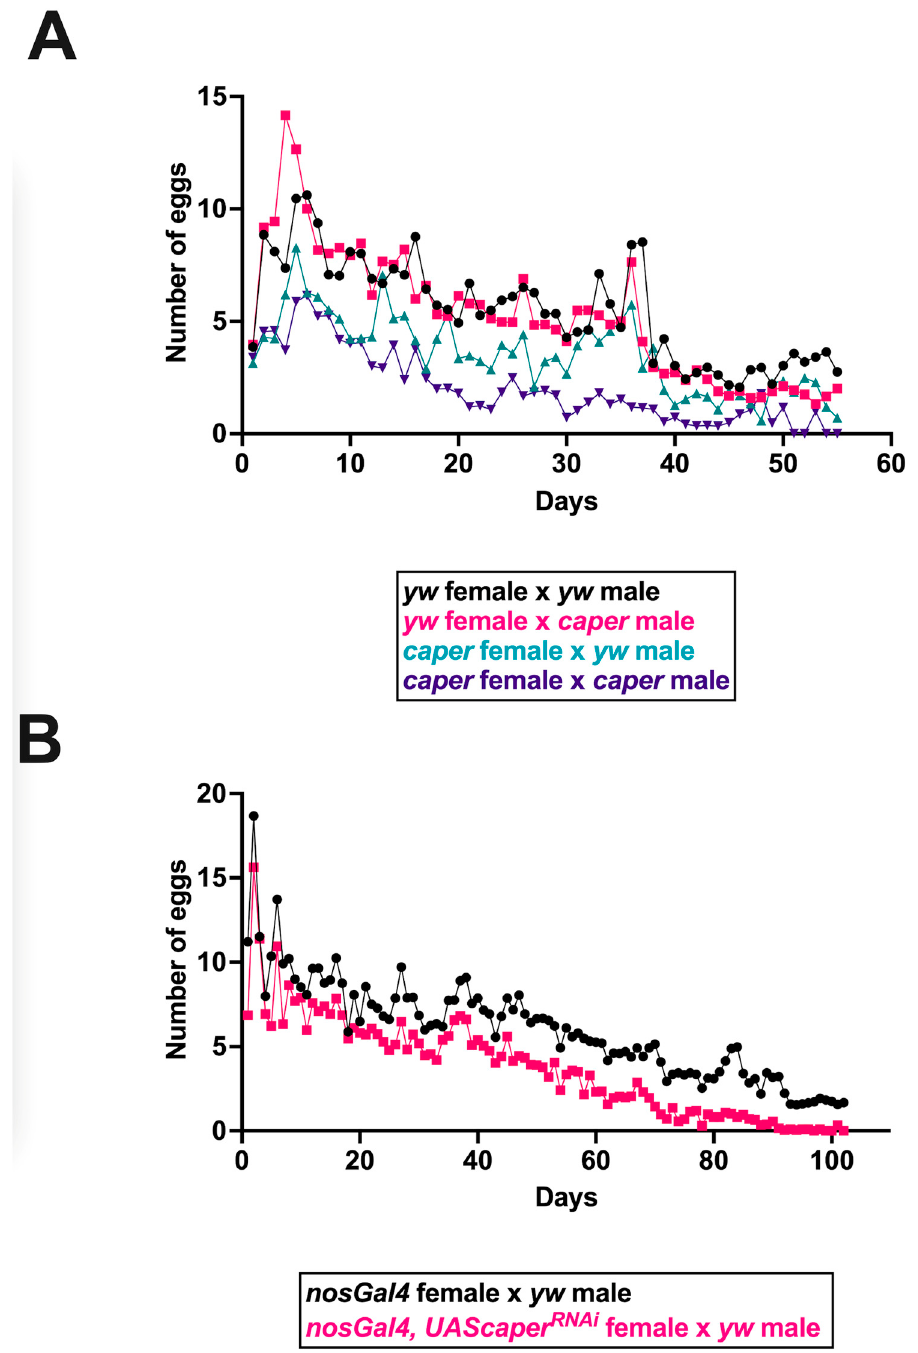
Figure 2. Reproductive output is decreased with caper dysfunction. ( A ) Reproductive output is affected in caper − / − females regardless of the genotype of the males they are mated with, and these deficits are increased with age. However, caper − / − females mated with caper − / − males show the greatest reduction in reproductive output. In each of the four genotypic pairings, 25 vials of 5 females each were scored. Statistical analysis of reproductive output revealed a significant female x male x day interaction (GLMM: χ 2 = 35.4, p = 2.70 × 10 − 9 ). ( B ) Knockdown of caper specifically within the germline using nanosGal4 also results in a decreased reproductive output compared to nanosGal4 female controls and this phenotype was exacerbated by age (GLMM: genotype x day interaction, χ 2 = 240.0, p = 2.2 × 10 − 16 ). In both genotypic pairings, 25 vials of 5 females each were scored. The number of eggs laid is plotted on the y -axis, with the age of the female in days plotted on the x -axis. Genotypes are indicated in the legend for each panel using color coding.